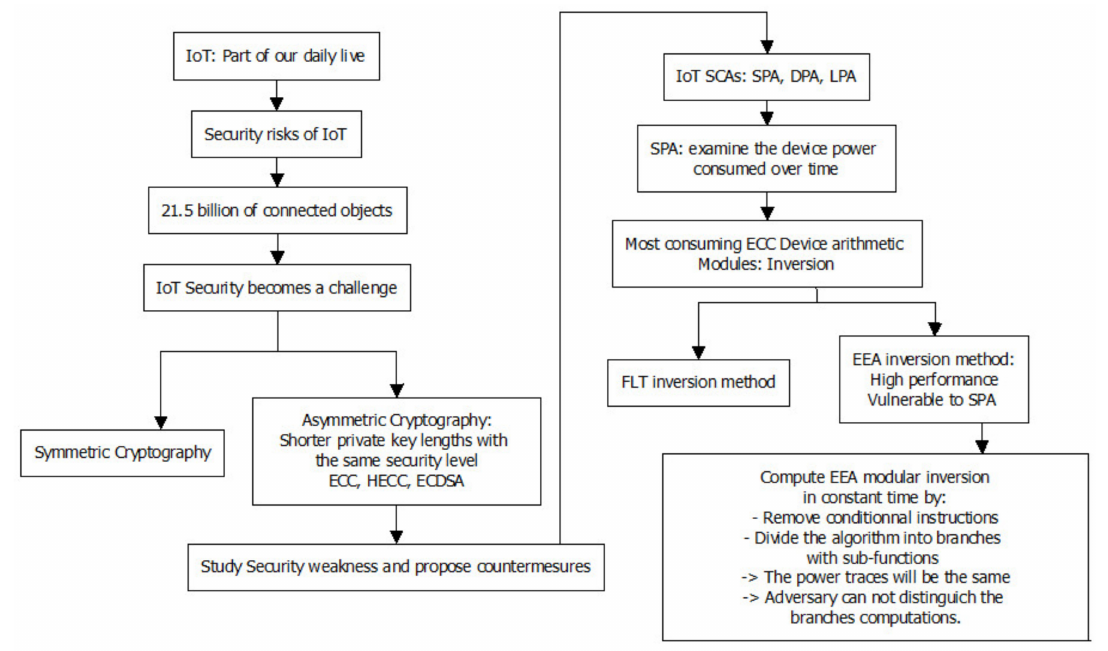
Figure 2. UML class diagram of IoT/modular